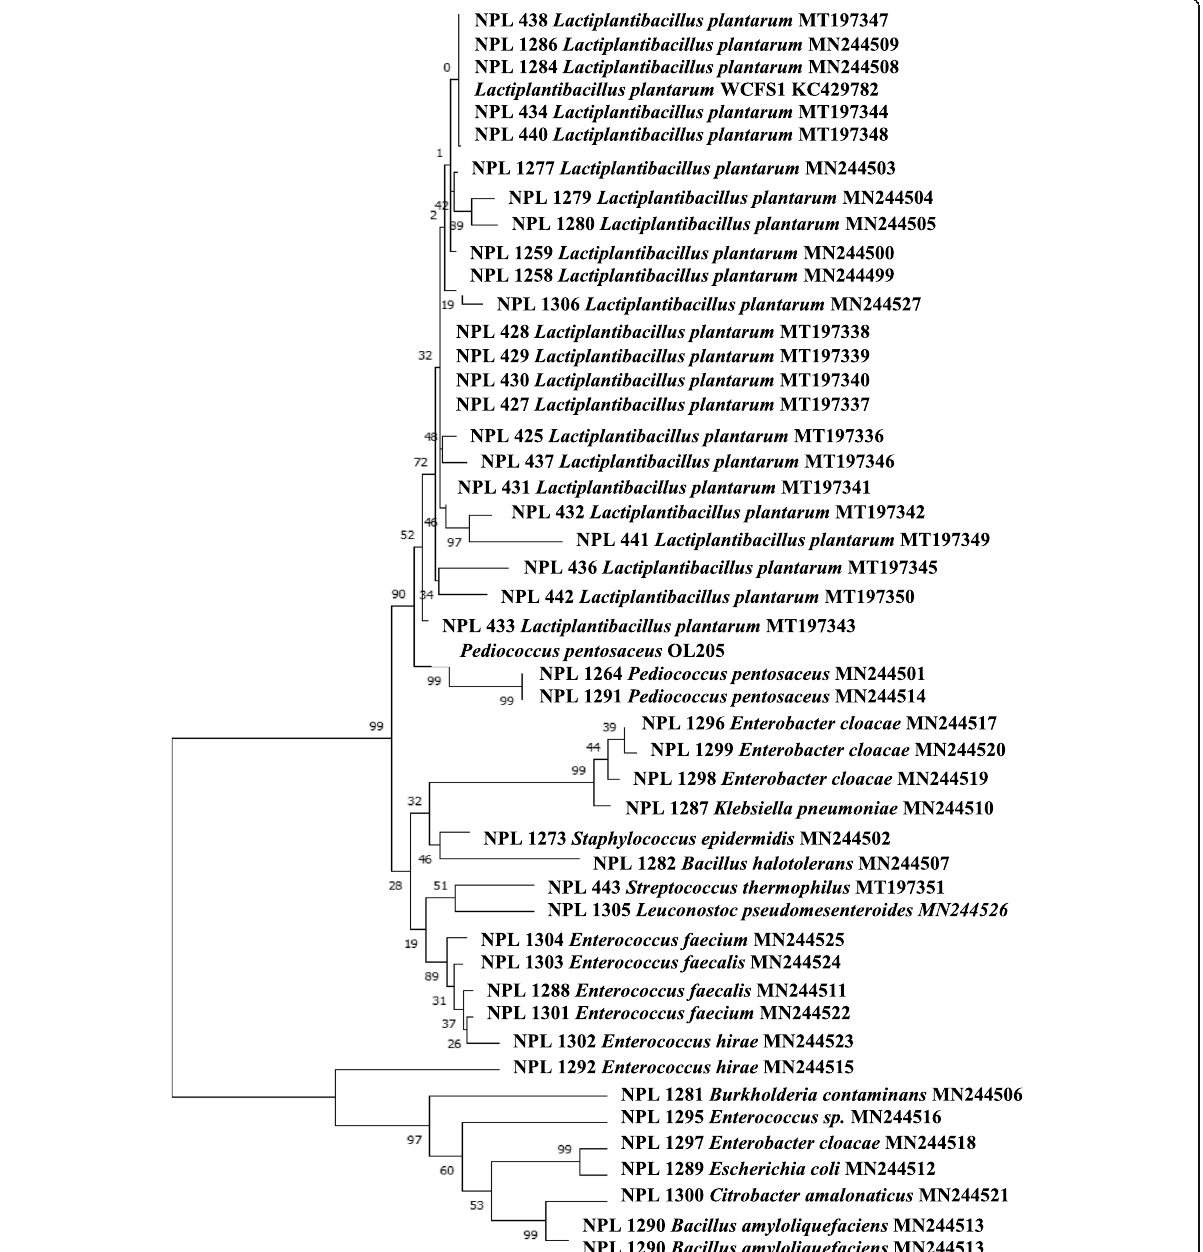
Fig. 1 Molecular phylogenetic analysis. The maximum-likelihood method based on the Kimura 2-parameter model was used with 100 bootstrap replicates. Branches corresponding to partitions reproduced in less than 50% bootstrap replicates are collapsed. The percentage of replicate trees in which the associated taxa clustered together in the bootstrap test (1000 replicates) is shown next to the branches. Evolutionary analyses